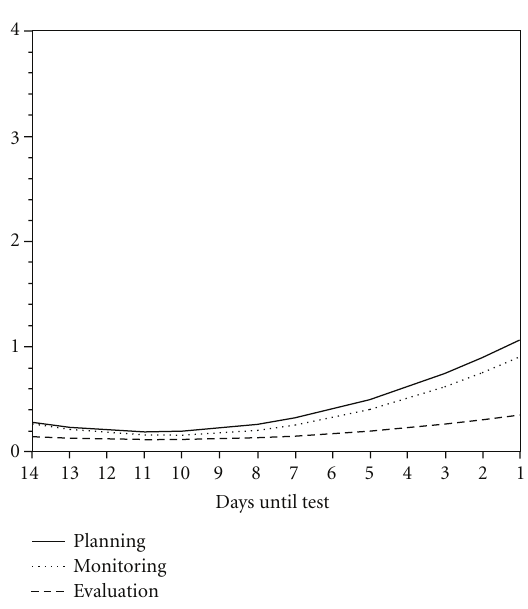
Figure 4: Change in frequency of planning, monitoring, and evaluation strategy use.